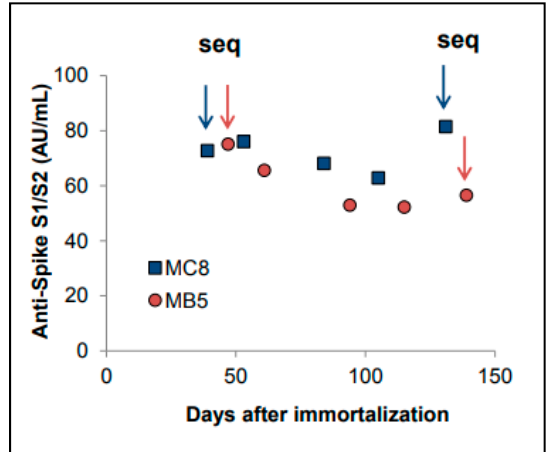
Figure 2. Stability of expression of IgG by MB5 and MC8 clones during culture. The anti-spike antibody levels in the supernatants of the 2 clones were measured at different times during long-term culture. The RNA was extracted at the 2 time points indicated by arrows and VH-VL regions amplified and sequenced. Identical sequences were obtained from early and late cultures of MB5 and MC8.